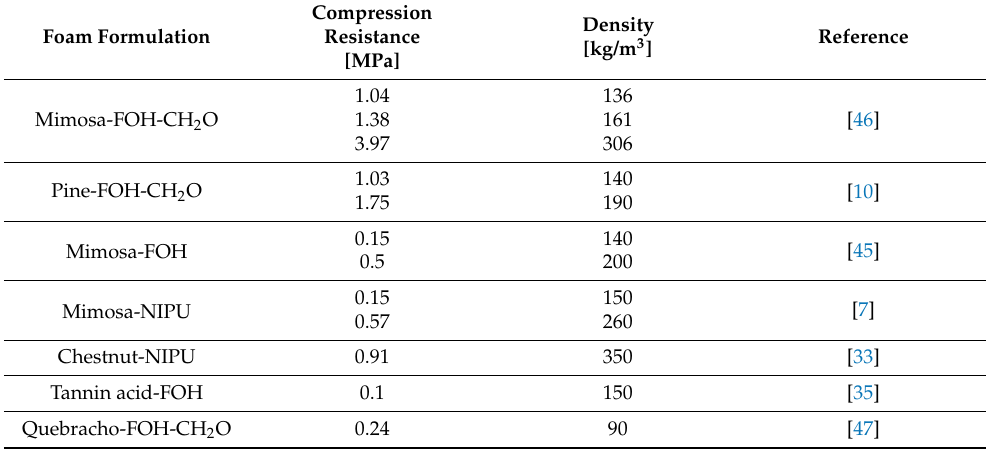
Table 2. Literature comparison of tannin-based foams with densities between 90 to 350 kg/m 3 . Foam Formulation